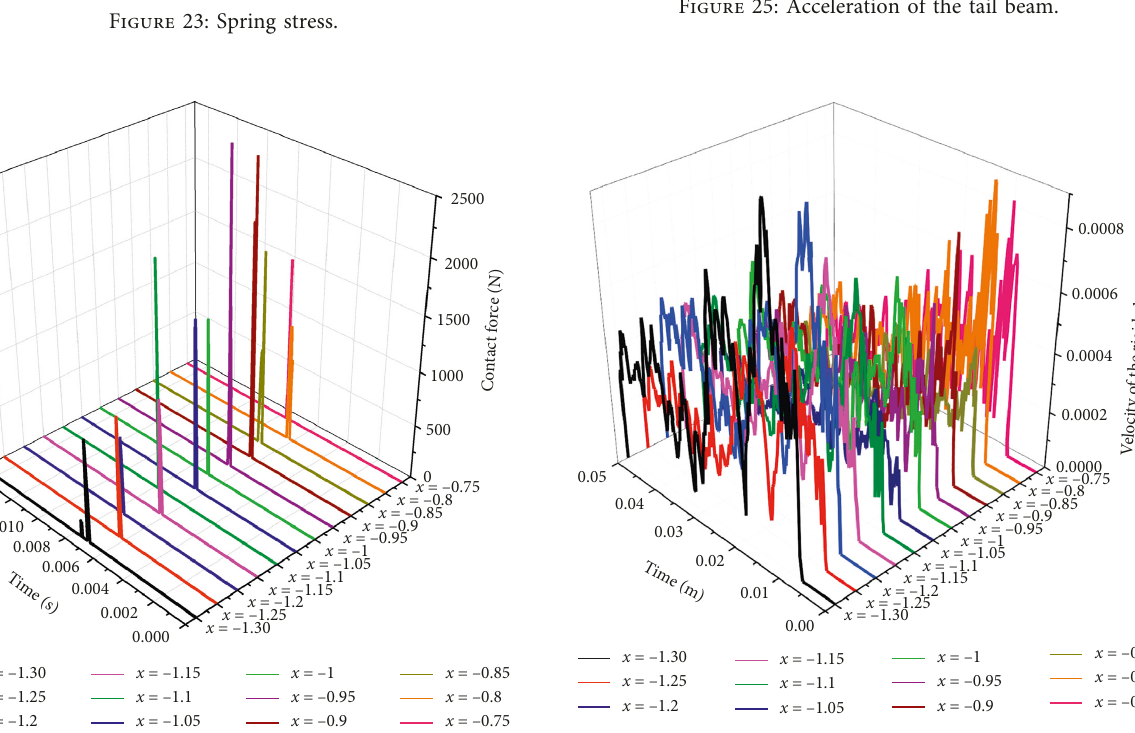
Figure 24: Contact force.